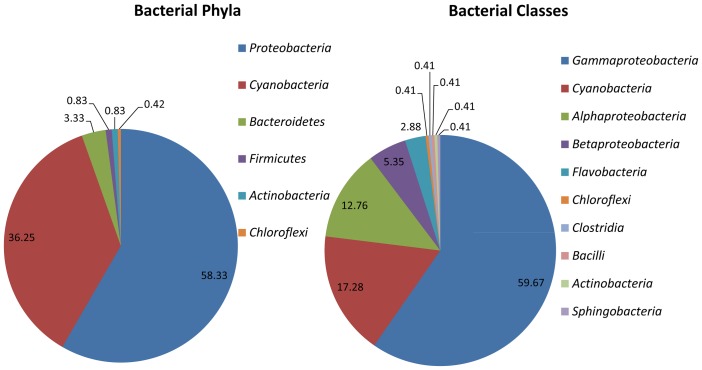
Relative abundance and diversity of bacterial phylum and classes in South African mine water.